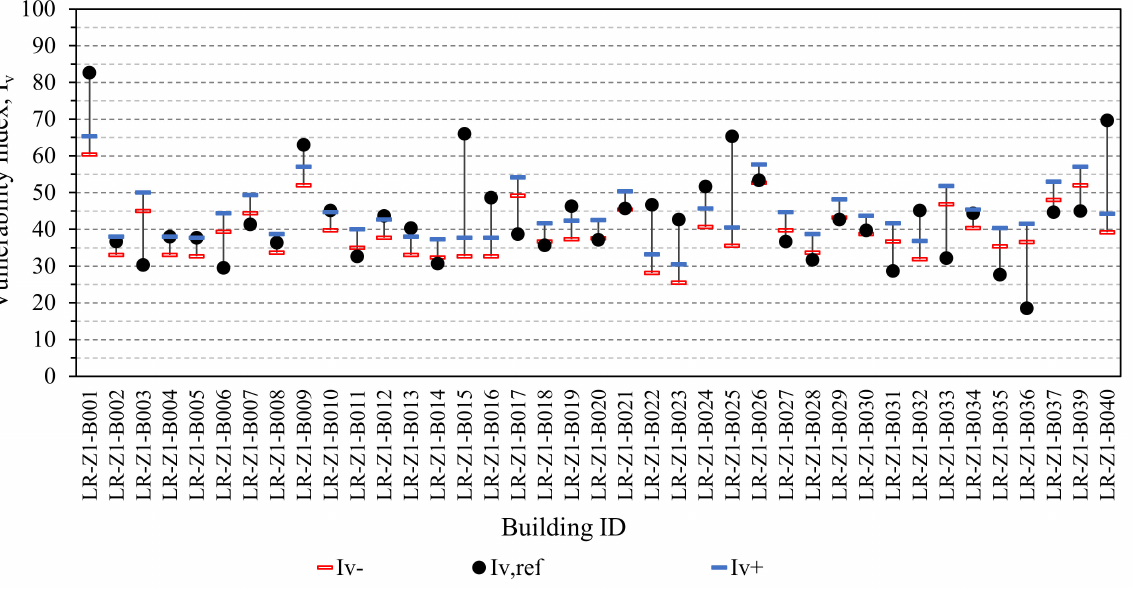
Figure 8. Comparison between the reference vulnerability index and the computed ranges by using remote surveying; the Building ID refers to the keys in Figure